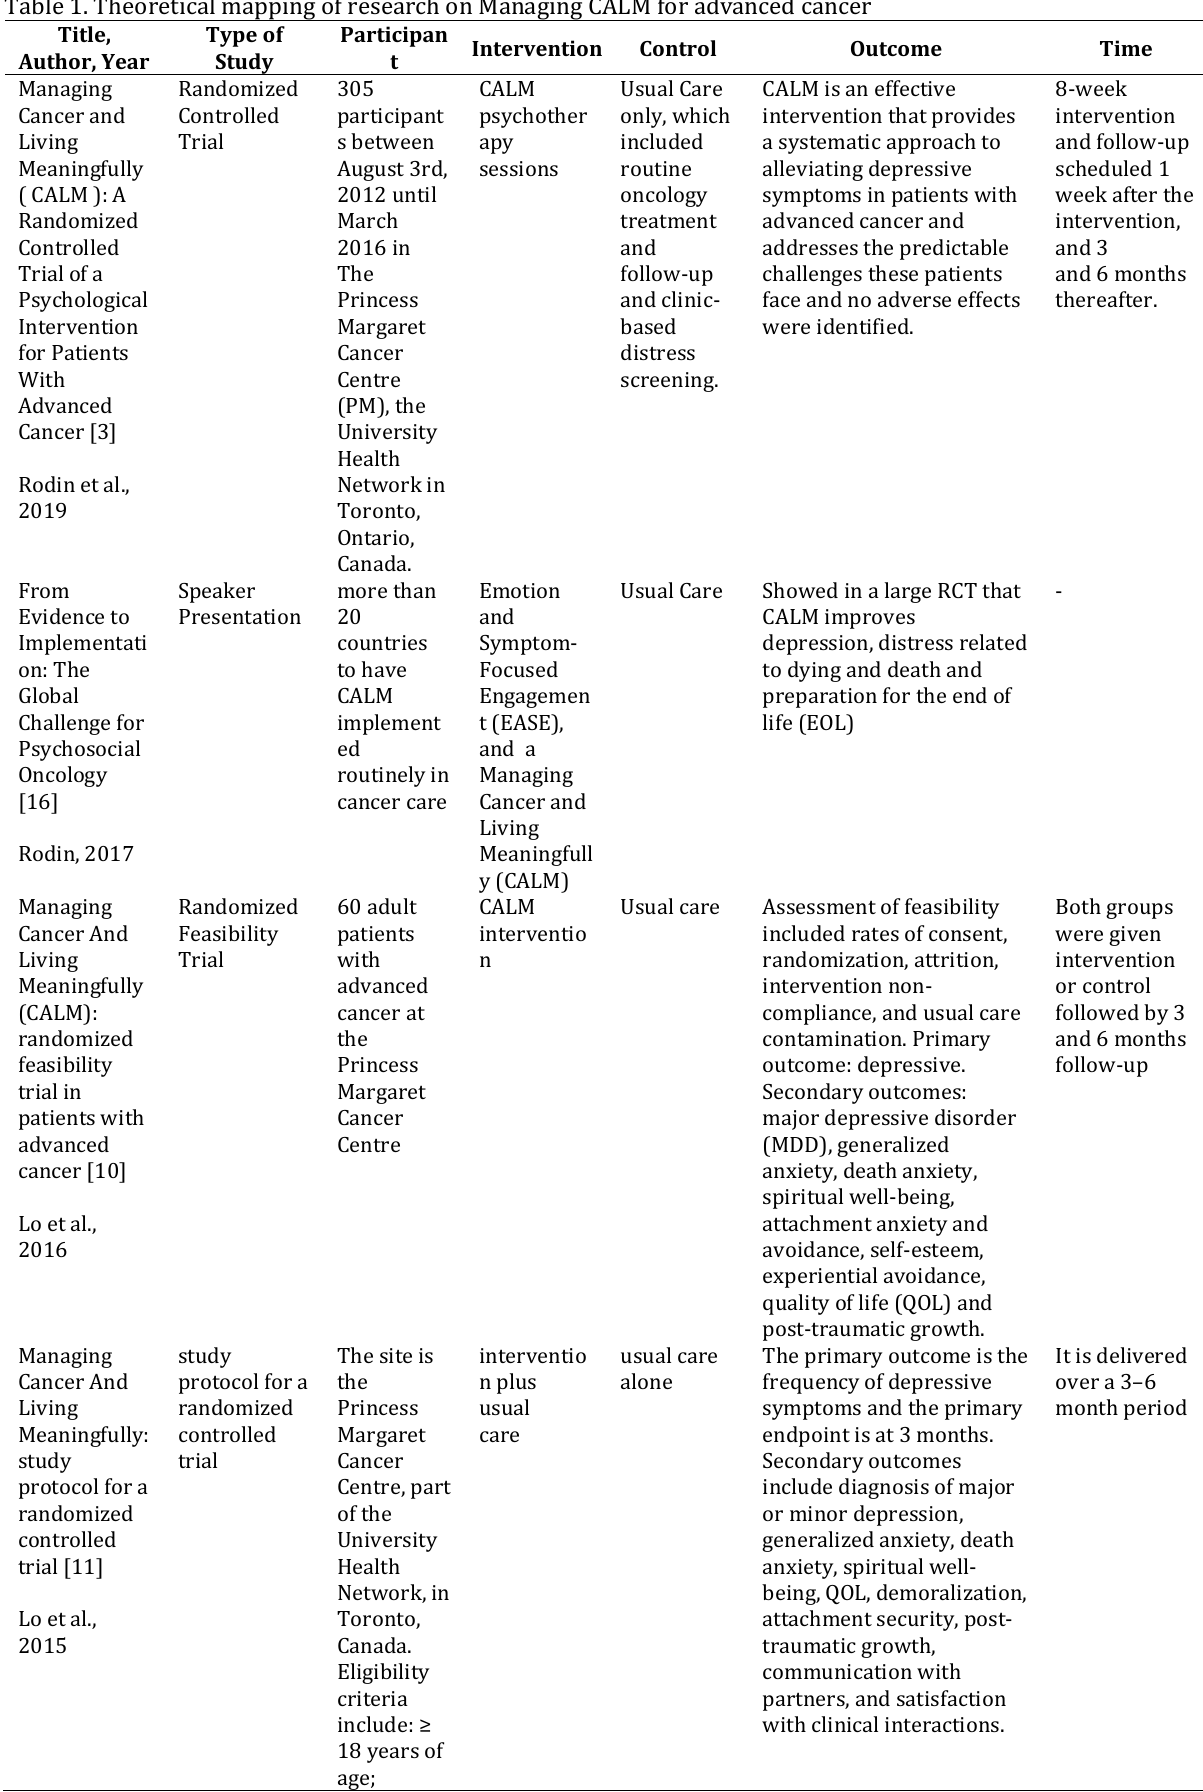
Table 1. Theoretical mapping of research on Managing CALM for advanced